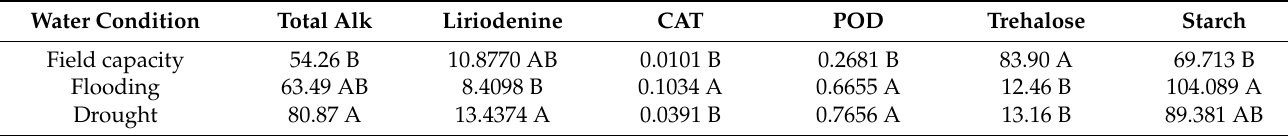
Table 2. Biochemical variables: liriodenine ( µ g.g − 1 ), total alkaloids ( µ g.g − 1 ), peroxidase (POD, µ mol prupurogallin Figure 3. Chromatogram indicating liriodenine obtained from young A. crassiflora plants submitted to three water condition levels [Field Capacity ( − 0.01MPa); Flooding and Drought ( − 1.5MPa)] at 18 days after the beginning of treatments.